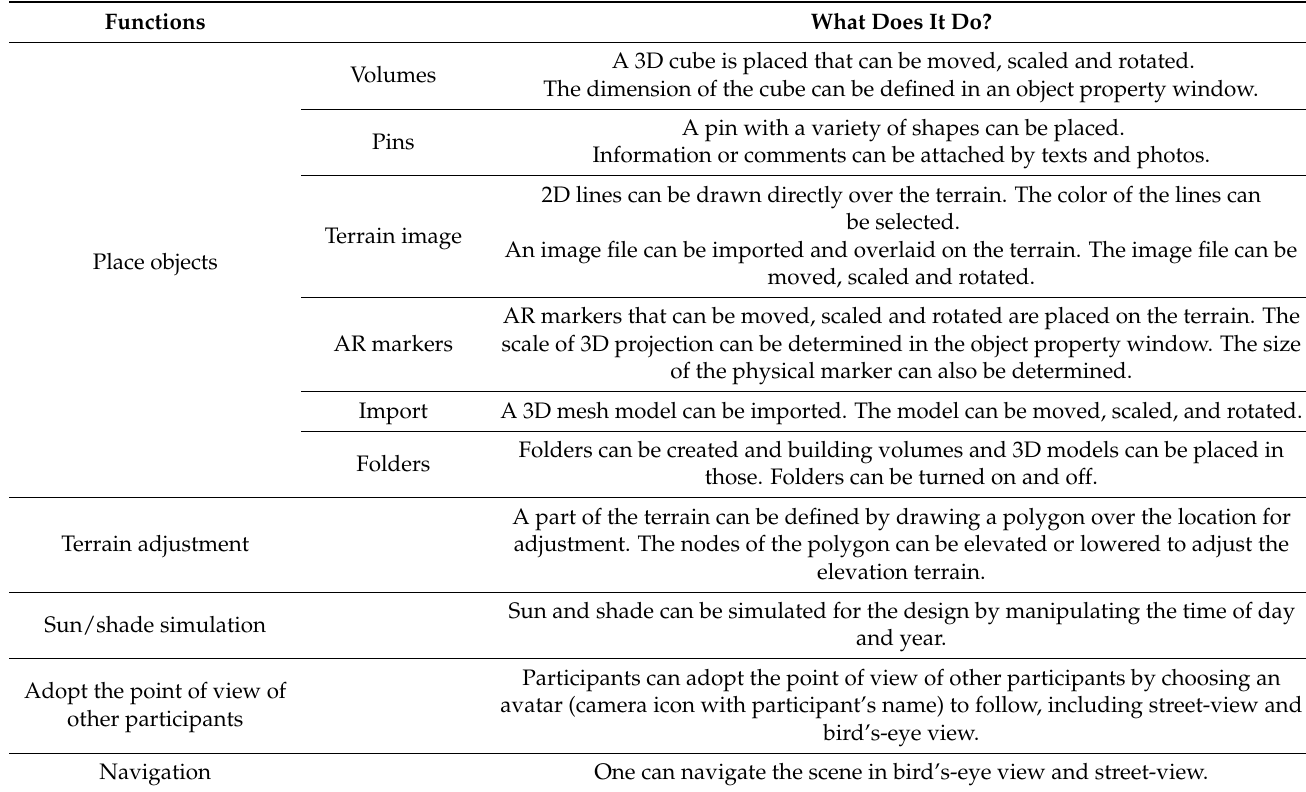
Table 2. Functions of the